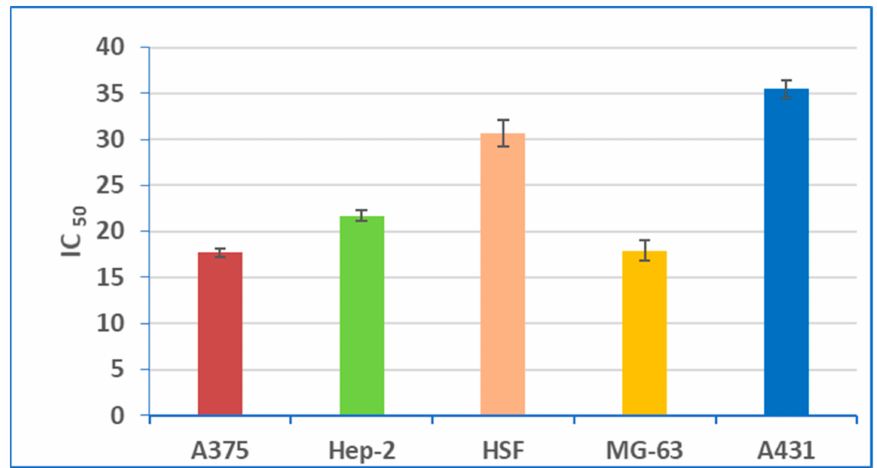
Figure 4. The values of IC 50 of YGME against different investigated cell lines. Table 2. The antimicrobial potential of YGME against different microbial isolates.